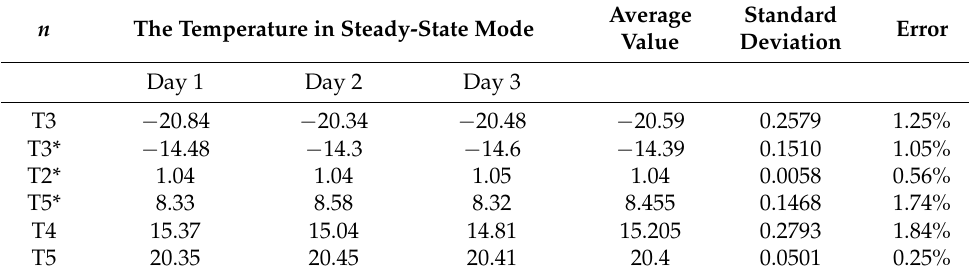
Table 3. Average values and errors.